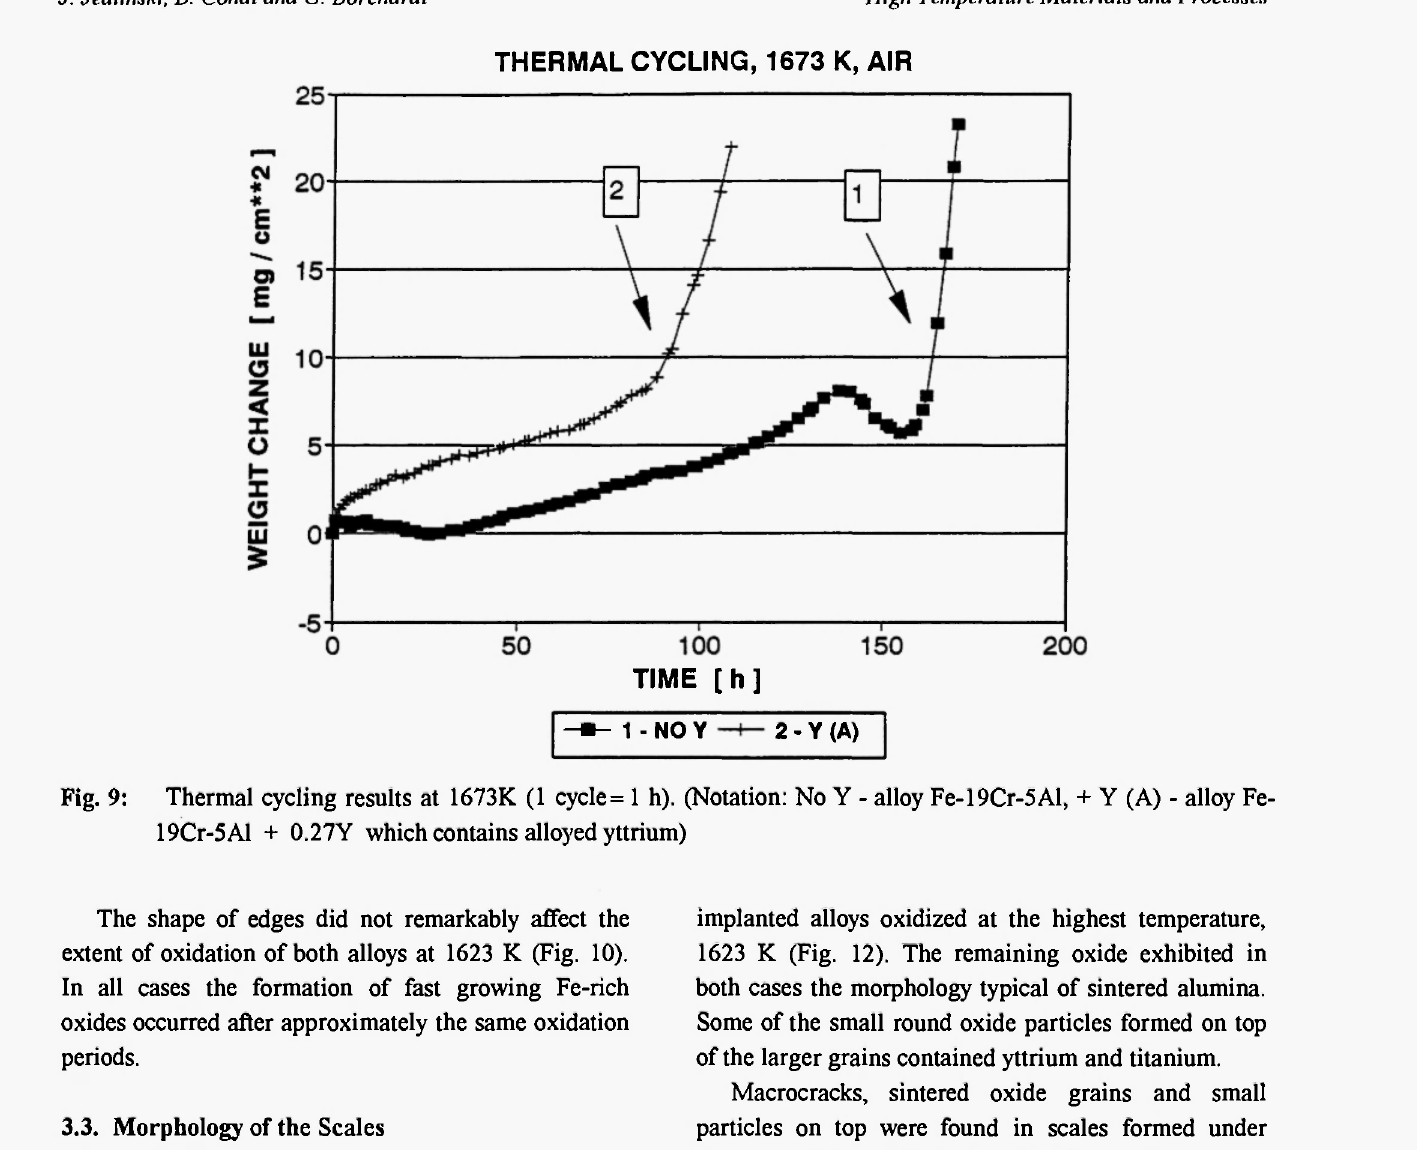
The shape of edges did not remarkably affect the extent of oxidation of both alloys at 1623 Κ (Fig.